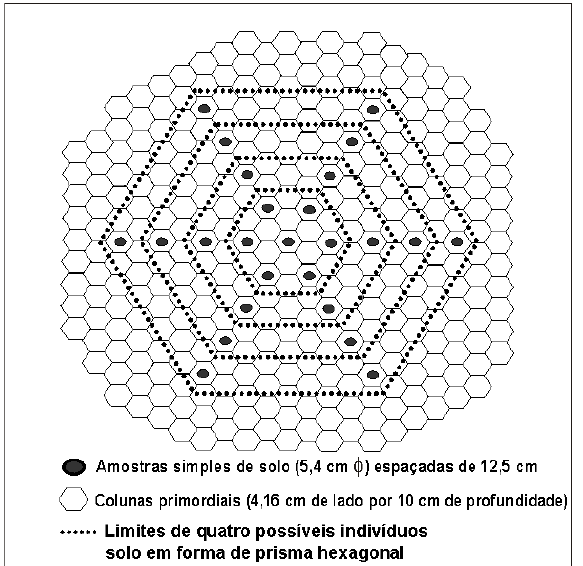
Figura 2. Modelo hipotético de quatro possíveis indivíduos-solo (unidades de amostra) em forma de prismas hexagonais, formados pelas respectivas colunas primordiais em forma de prismas hexagonais (4,167 cm de lado por